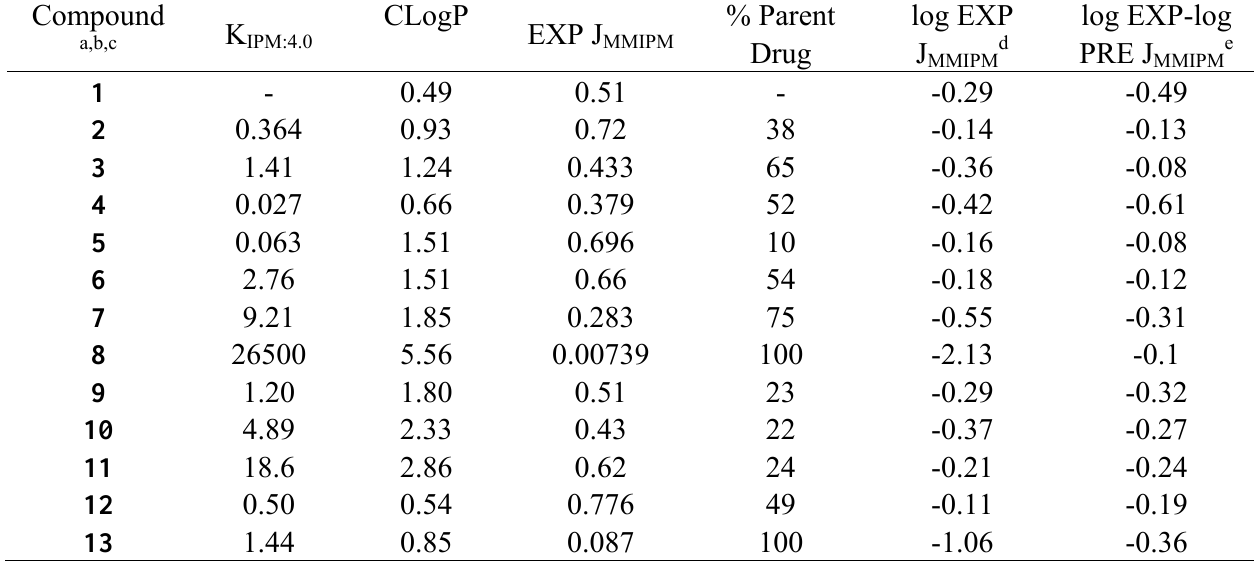
), Flux from IPM Table 2. Partition Coefficients Between IPM and pH 4.0 Buffer (K IPM:4.0 Through Hairless Mice Skins (J ), Percentage of Parent Drug Obtained After MMIPM Permeation Through Hairless Mice Skins of AOCOM, NANAOCAM and AOC prodrugs of APAP and log EXP- log PRE J MMIPM